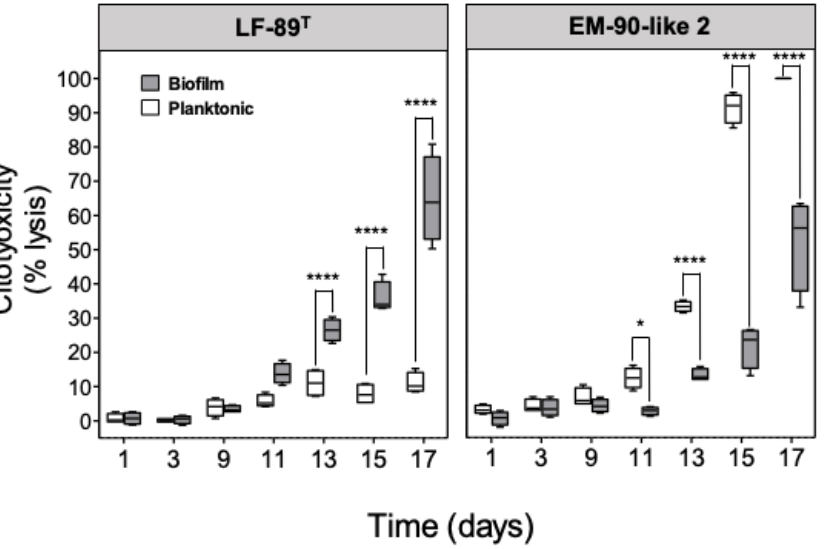
Figure 2. Cytotoxicity assay in SHK-1 cells infected with planktonic and sessile P. salmonis . SHK-1 cells were infected with planktonic or sessile P. salmonis (MOI = 10). Results are expressed as cytotoxicity percentage means ± standard error of each sample in triplicate. Asterisks indicate significant differences (* p < 0.05 and **** p < 0.001).